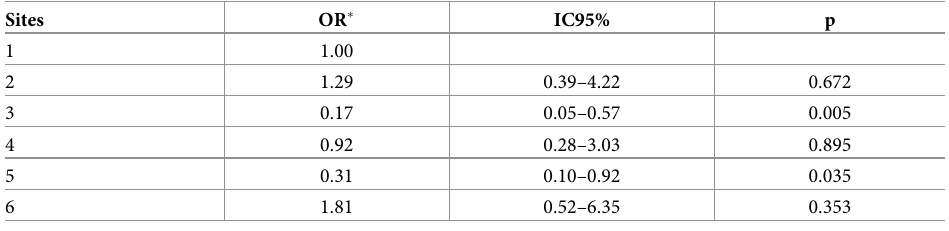
Table 3. Generalized Lineal Model with binomial error indicating trapping site as a factor for trombiculid infesta- tion in rodents (n = 244) on Chiloe´